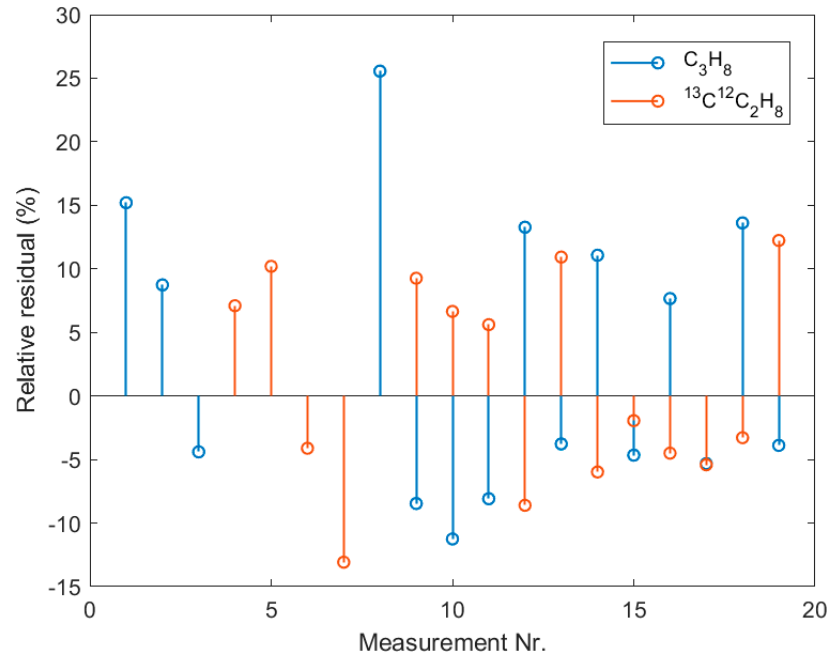
Figure A6. Cross validation relative residual of the ICL 1638 measurements.